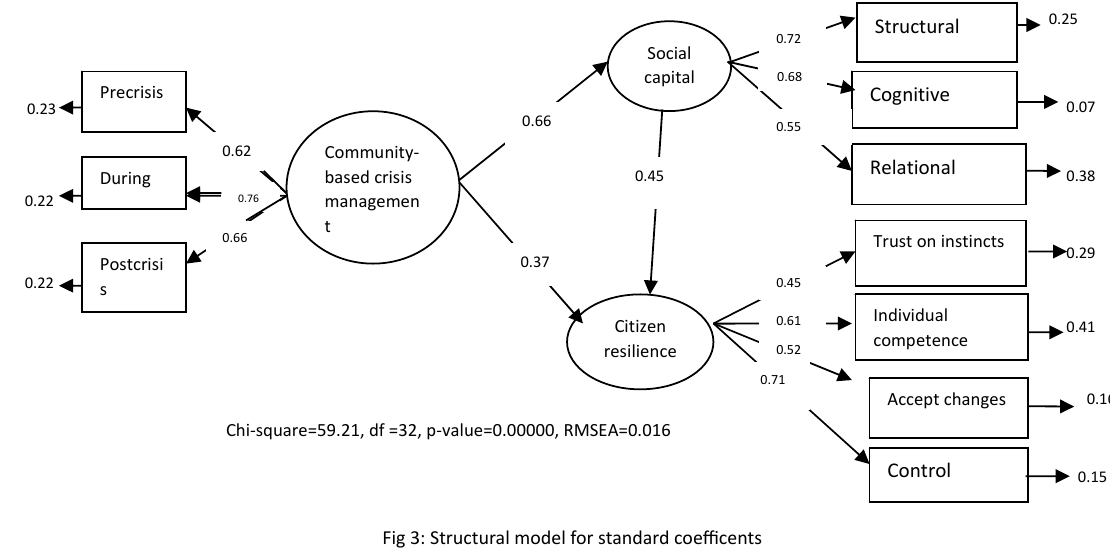
Fig 3: Structural model for standard